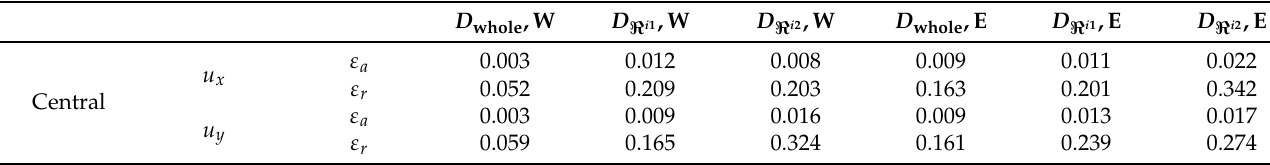
Table A8. Absolute and relative errors for the heterogeneous neighbourhood (Central) and the optimal vortex set, Equation